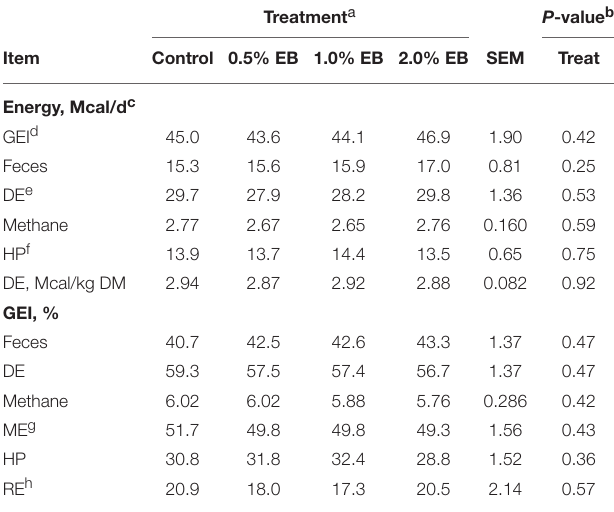
TABLE 6 | Nitrogen balance of beef heifers fed a barley silage-based diet containing increasing addition of enhanced biochar (EB; n = 8 per treatment). Treatment a P - value b